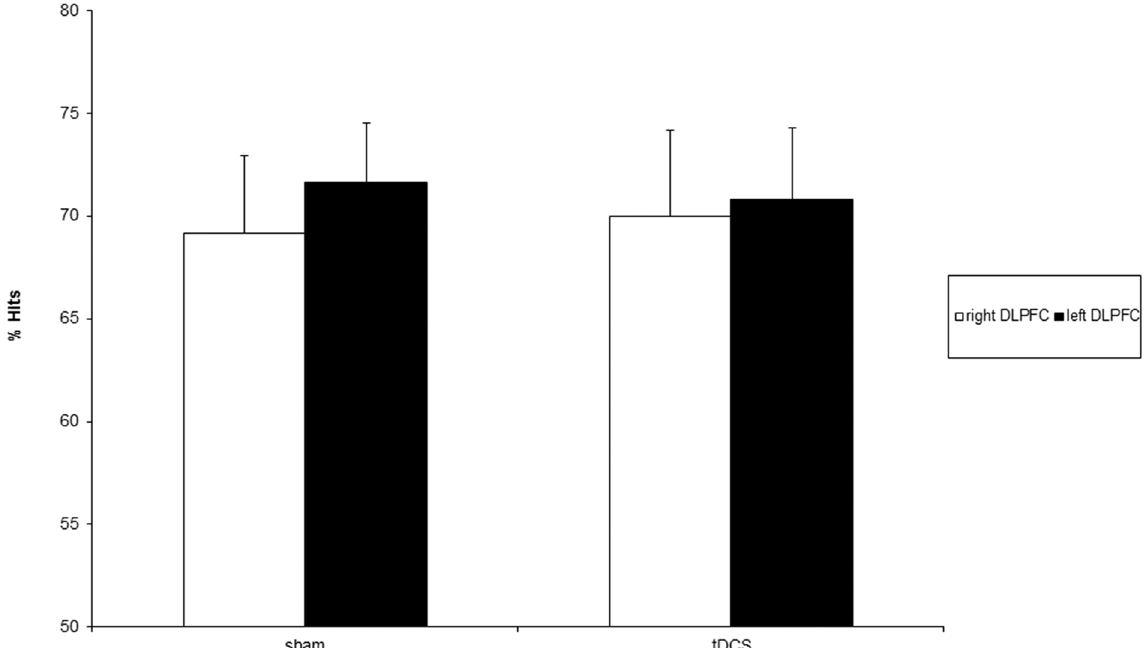
Fig 2. percentage of hits following sham and real anodal tDCS of the right (white bars) and left (black bars) DLPFC. Error bars represent 1 SE of mean.